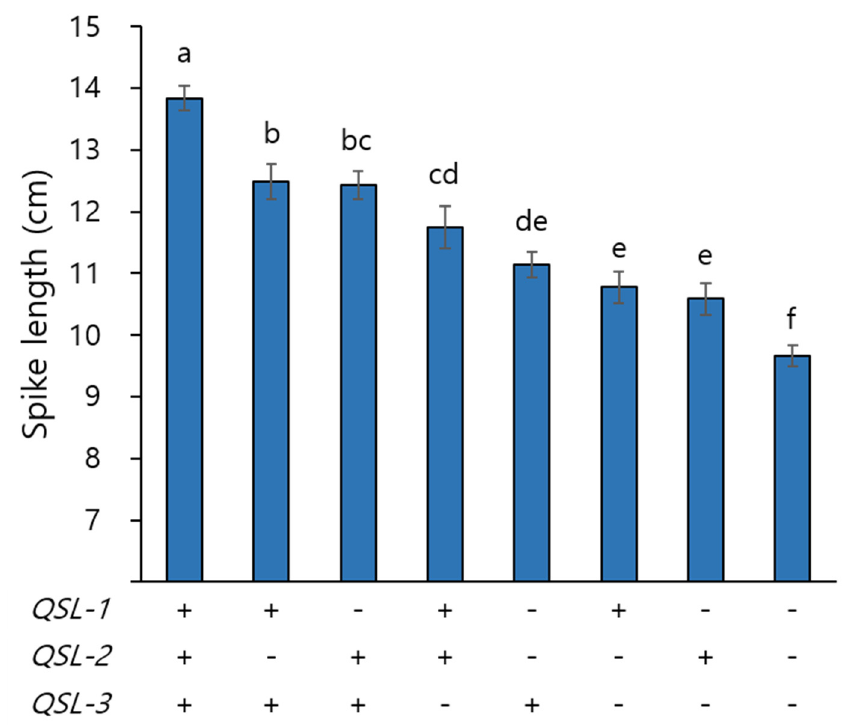
Figure 5. Spike length of the RILs carrying different allele combinations of QSL-1 , QSL-2 , and QSL-3 . The symbol “+” indicates the Taejoong allele for a long spike while “-” indicates the Keumkang allele for a short spike. QSL-1 , QSL-2 , and QSL-3 were represented by the markers AX-94918964 , AX-94831718 , and AX-94602621 , respectively. Different letters above the bars indicate that there was significant difference from Duncan’s multiple range test at p < 0.05. Error bars indicate standard errors.